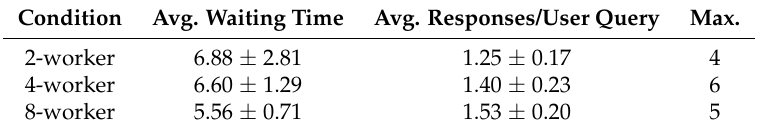
Table 7. Average waiting time for eliciting multiple responses (first column), avg. responses per user query and maximum responses per condition